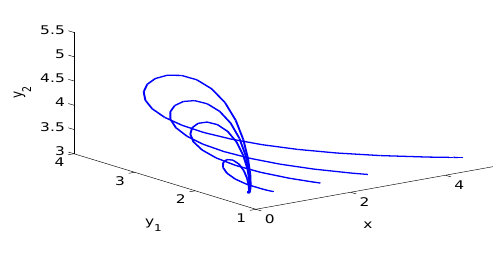
Figure 2: m = τ = 0 , E * = (0.5168, 1.5330, 3.0660) of system (1.4) with different initial values is locally asymptotically